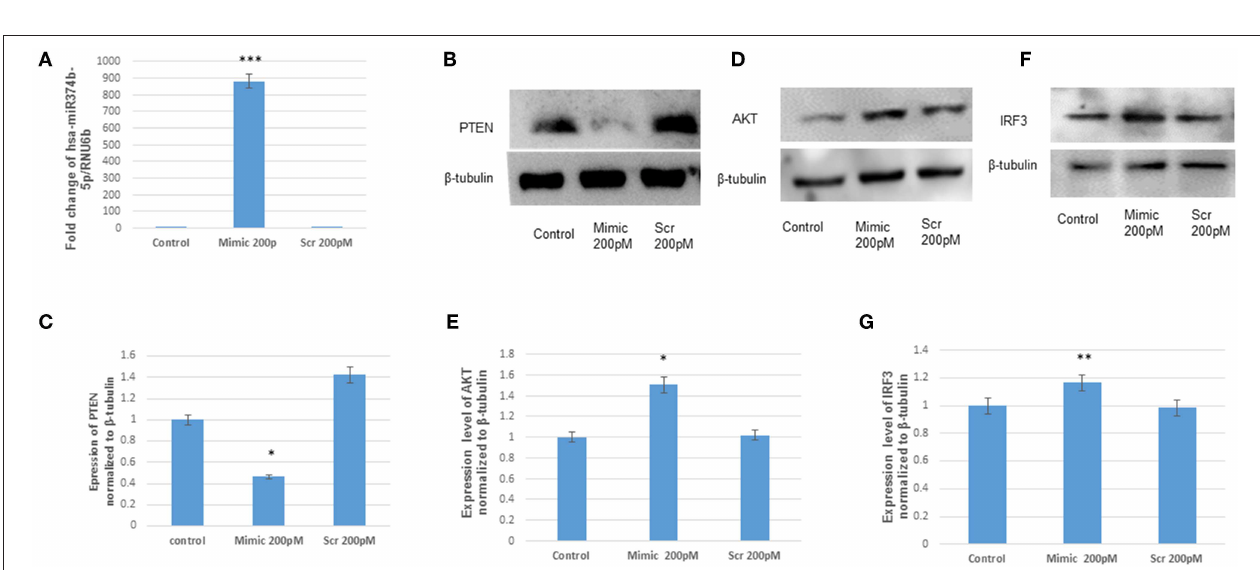
FIGURE 2 | The differential expression of hsa-miR-374b-5p after JEV (JaOARs982 strain) infection in human microglial cells. The change in hsa-miR-374b-5p after JEV (JaOARs982 strain) infection at different time points. The qRT-PCR by using TaqMan microRNA assay shows the up-regulation from 24h to 48h by 2.5–5-folds compared to control. The data are shown as mean ± S.E from three independent experiments ( n = 3 ). The fold change is significant where * denotes P < 0.05, ** denotes P < 0.01, *** denotes P < 0.001.